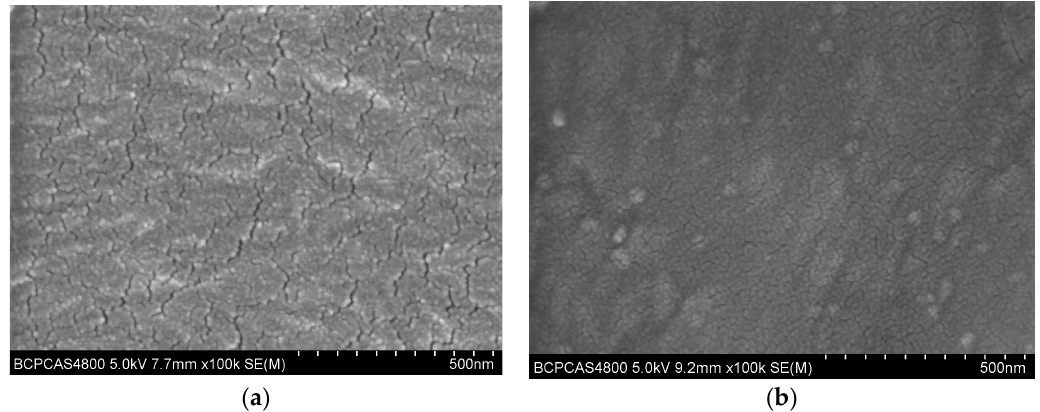
Figure 2. SEM morphology of SiOx coatings grown on a - preistine PE, b - Ar+ ethanol plasma-treated PE+ SiOx.